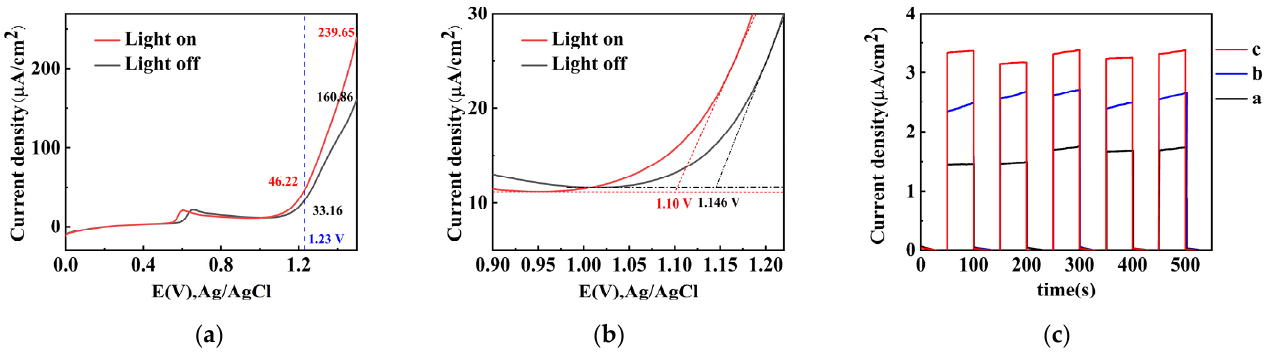
Figure 7. ( a ) LSV of (g-C 3 N 4 NSs/ Mn 6 SiW) 2 film electrode in light on( red ) and light off ( black ); ( b ) The locally enlarged graph of ( a ); ( c ) amperometric i–t Curve of the (g-C 3 N 4 /PSS) 2 film ( a ), (PDDA/Mn 6 SiW) 2 film ( b ), and (g- C 3 N 4 NSs/Mn 6 SiW) 2 film ( c ) under incandescent lamp irradiation (450–650 Table 1. The current density of PDDA/PSS/(g-C 3 N 4 NSs/Mn 6 SiW) 2 -ITO electrode. E (V vs. Ag / AgCl)